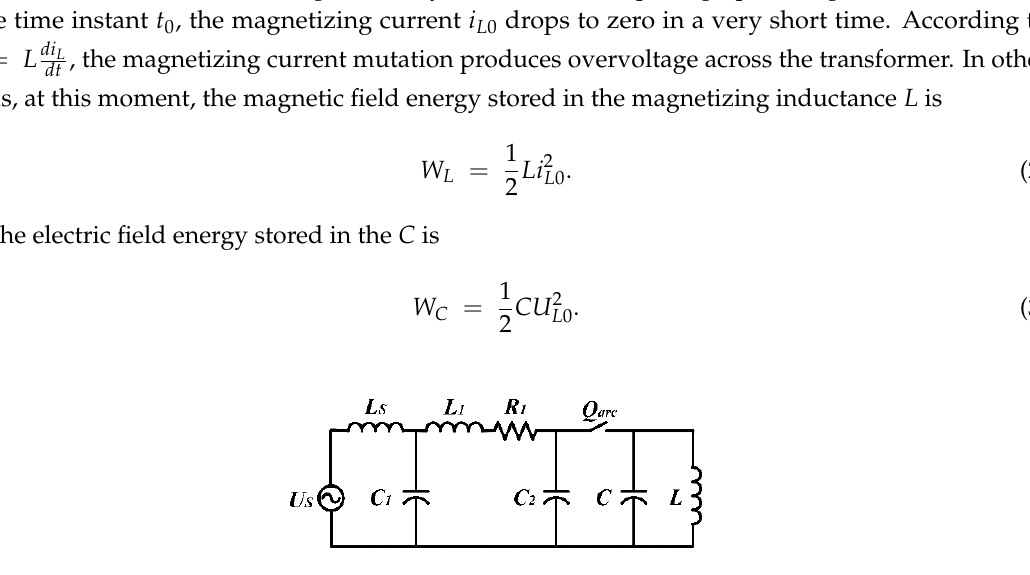
Figure 2. Simplified equivalent circuit for the traction system.